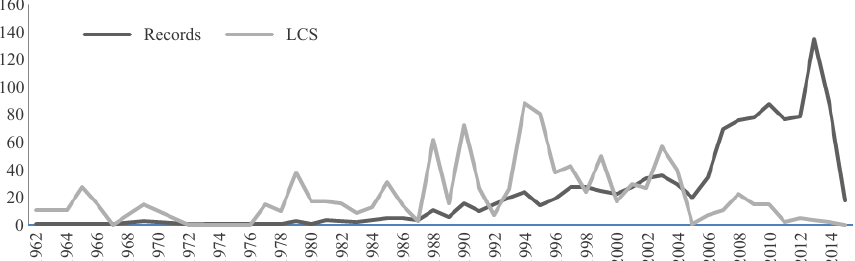
Fig. 1. Scientific productivity in the international competitiveness literature in the years 1945–2015 Source: own calculations on the local